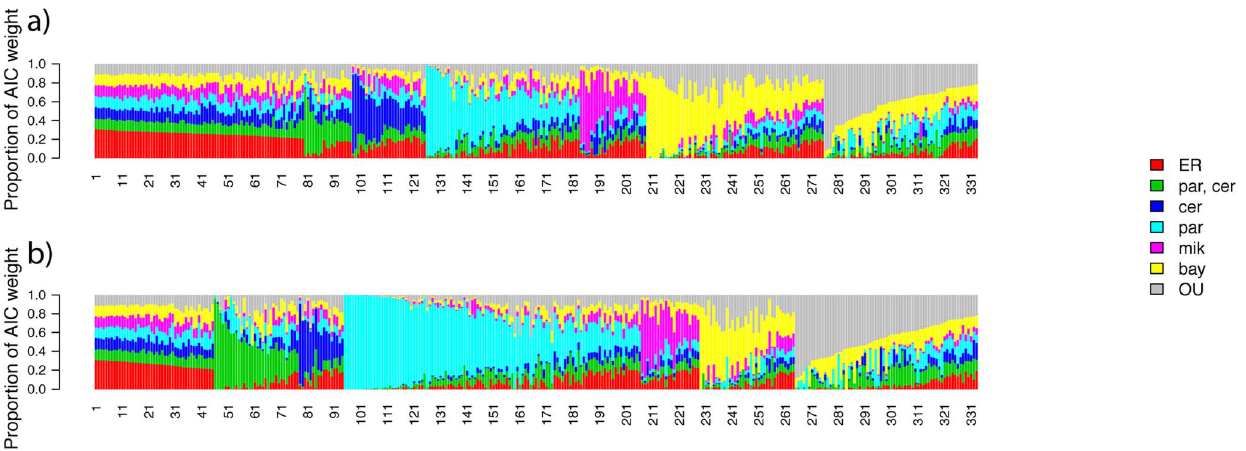
Figure 3. Inference of regulatory evolution in yeast pathways from experimental expression measurements. Each panel reports results of phylogenetic inference of evolutionary histories of gene expression change from one set of experimental transcriptional profiling data. In a given panel, each vertical bar reports results of maximum-likelihood fits of Brownian-motion and Ornstein-Uhlenbeck models to expression of the genes of one Gene Ontology process term; the total proportion of a bar corresponding to a particular color indicates the Akaike weight of the corresponding model (legend at right, with labels as in Figure 1). Bars are sorted by the model with maximum Akaike weight. (a), Inference of cis -regulatory variation from interspecies hybrids; numerical indices correspond to rows in Table S3. (b), Inference from measurements of total expression in species homozygotes; numerical indices correspond to rows in Table S4.